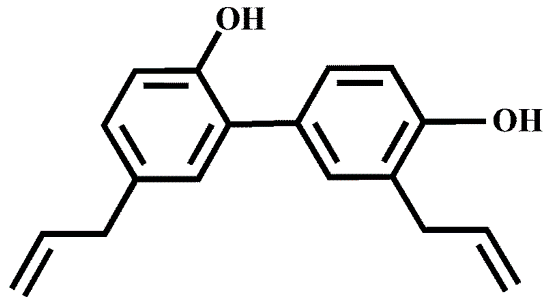
Figure 1. Chemical structure of honokiol.